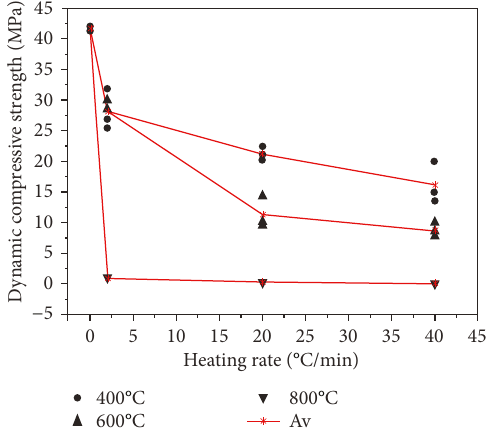
Figure 7: The correlation between dynamic compressive strength and heating rate.